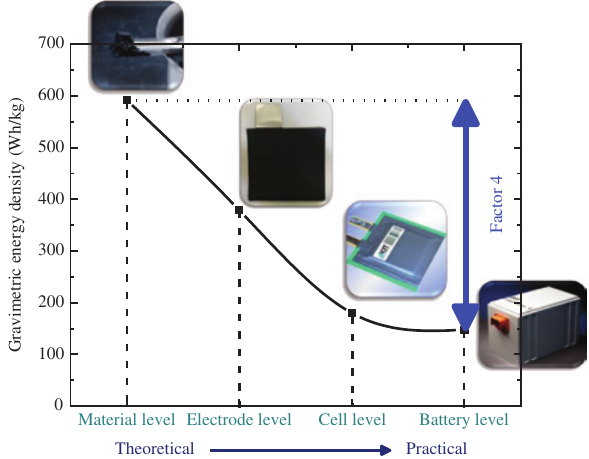
Figure 3: Theoretical [see equation (1)] and practical gravimetric energy density of NMC based on a standard 52 Ah pouch cell [26] and state-of-the-art battery packs